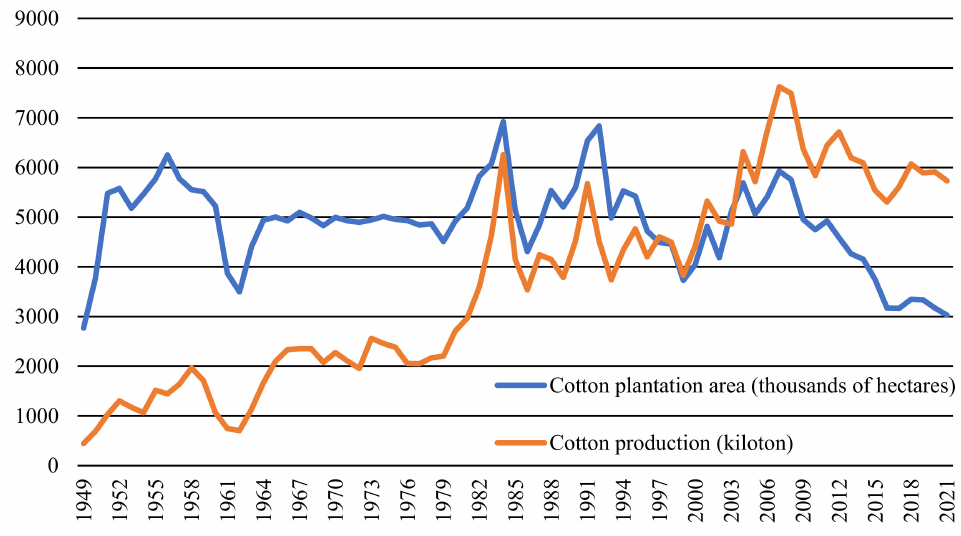
Figure 1. China’s cotton planting area and cotton production from 1949 to 2021.